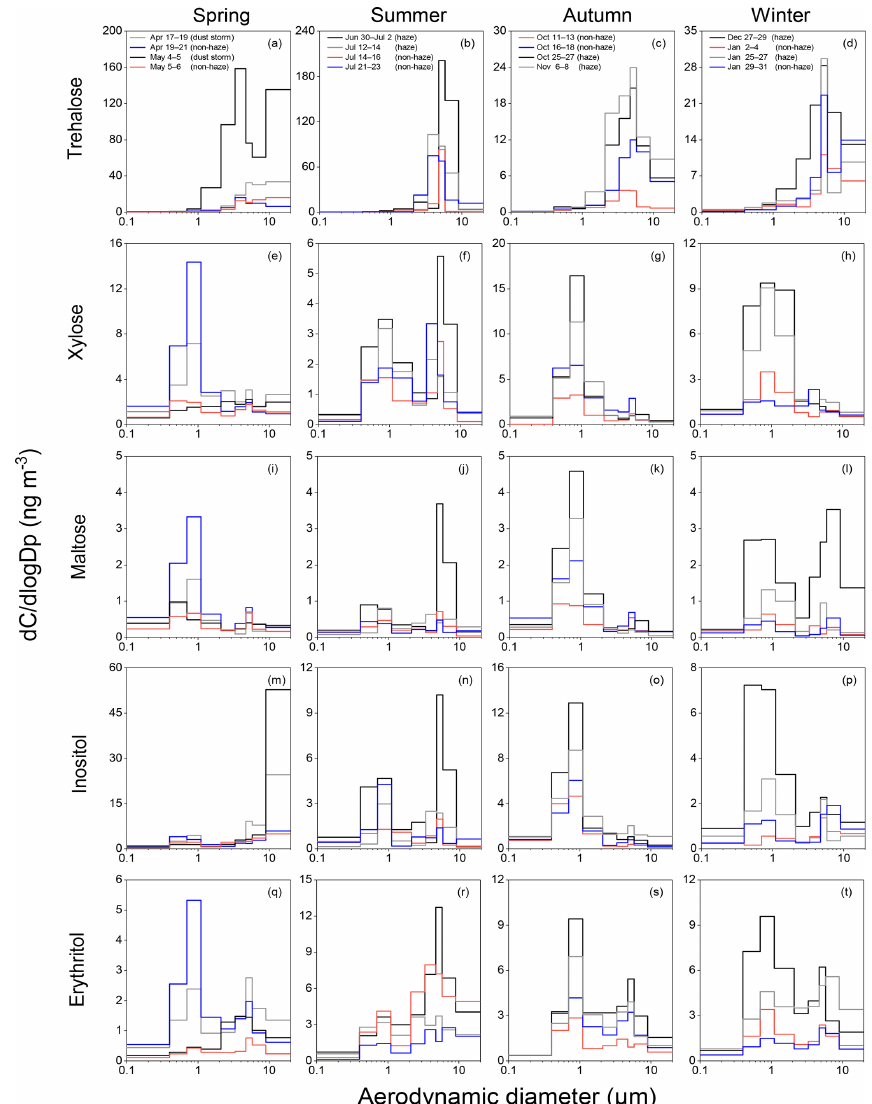
Figure 7. Size distributions of trehalose, xylose, maltose, inositol and erythritol in urban aerosols in Beijing.